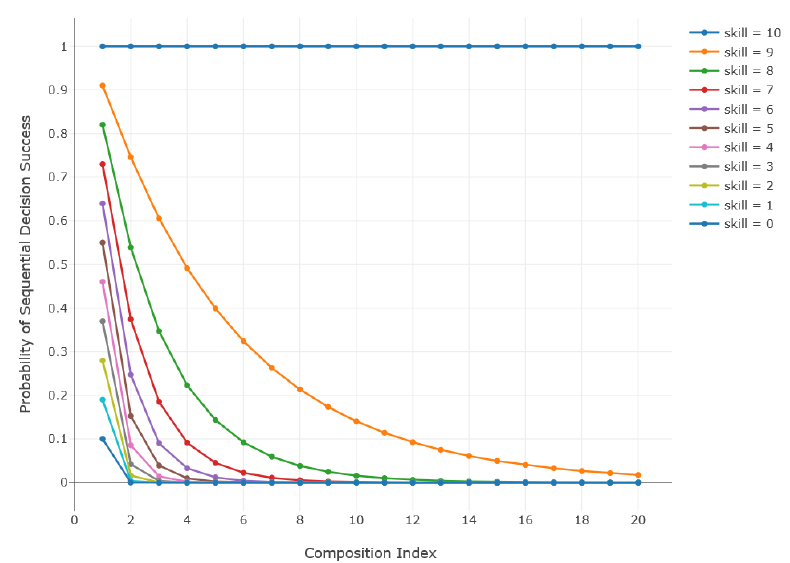
Figure 3. Probability of sequential decision